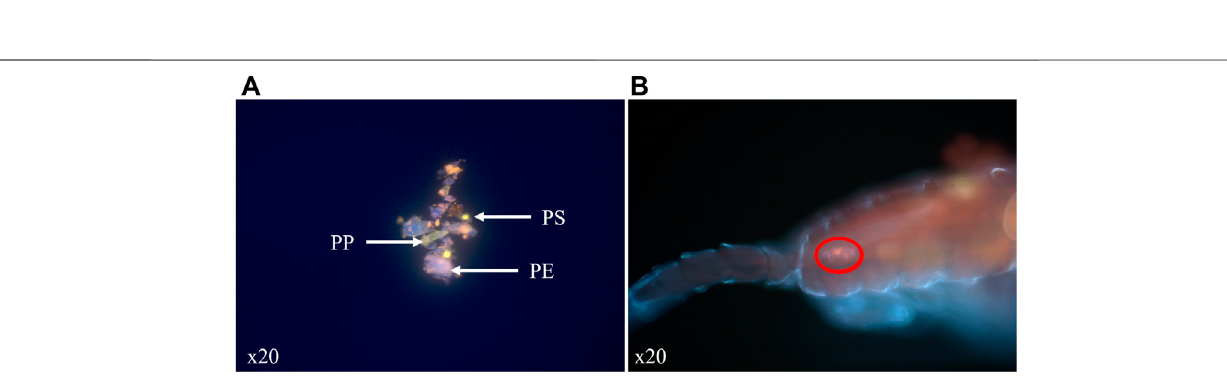
Frontiers in Environmental Chemistry |